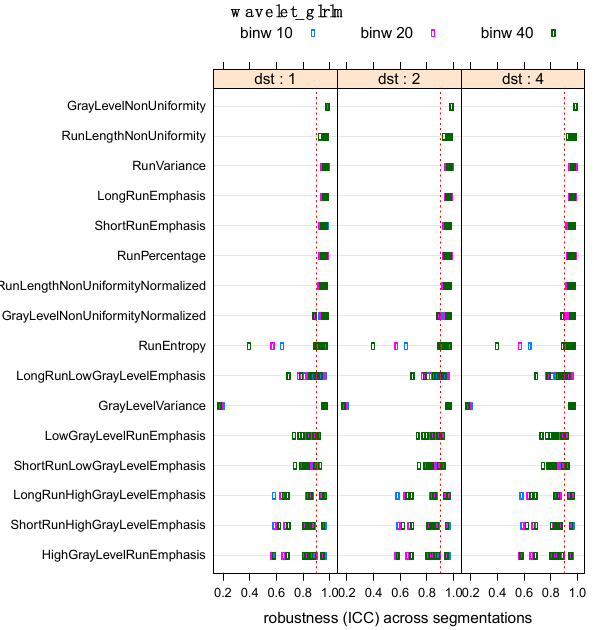
Figure 11. Robustness of wavelet-based second-order GLDM features across segmentations. The vertical dashed red line indicates the ICC > 0.9 threshold. Pyradiomics provides 14 such features. The robustness (ICC) is above 0.9 only for few of them. They are dependent on bin-width (binw: 10, 20, 40) and on (dst: 1, 2, 4). Because they are second-order, they are dependent on distance (dst) but they do not depend much on resolution or interpolator. However, the wavelet features are dependent on the direction used for wavelet computation (each circle on a line is a different gradient direction).